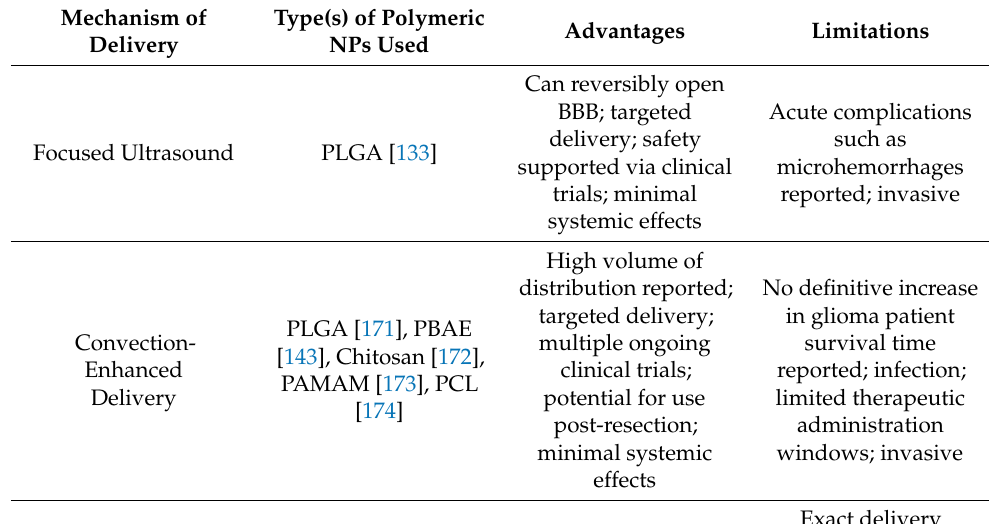
Table 2. Comparison of polymeric NP mechanisms of